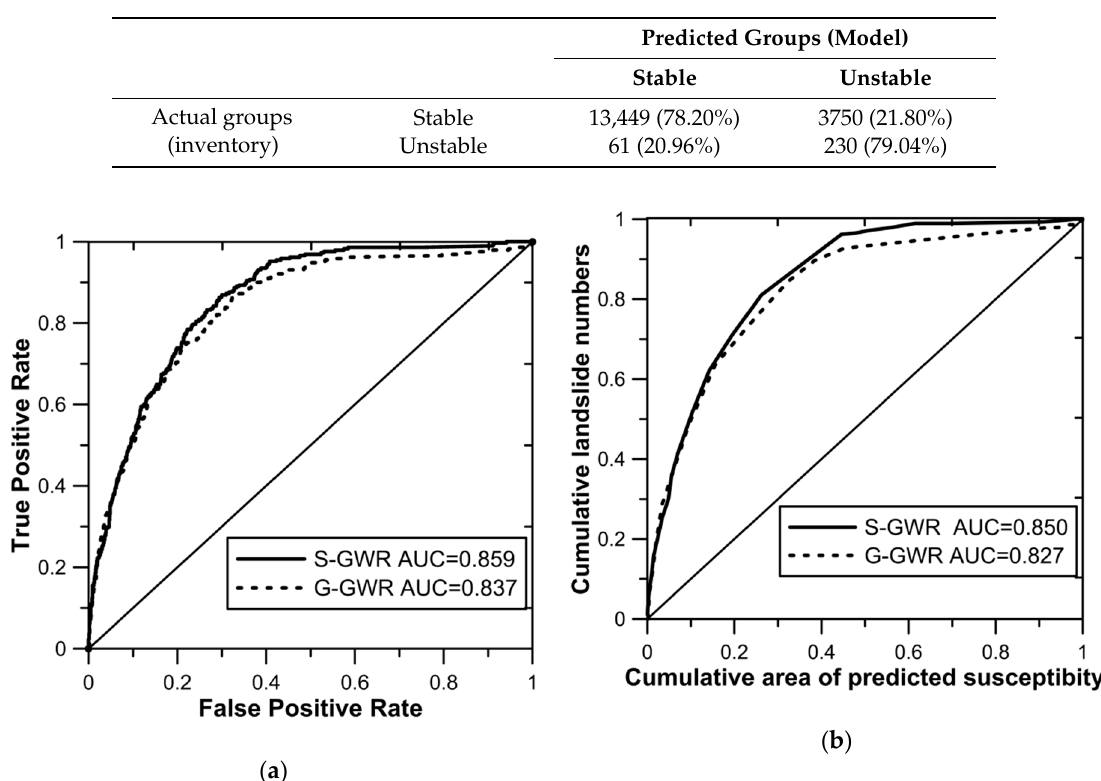
Figure 7. Validation of S-GWR and G-GWR models. ( a ) ROC curve; ( b ) success rate curve.